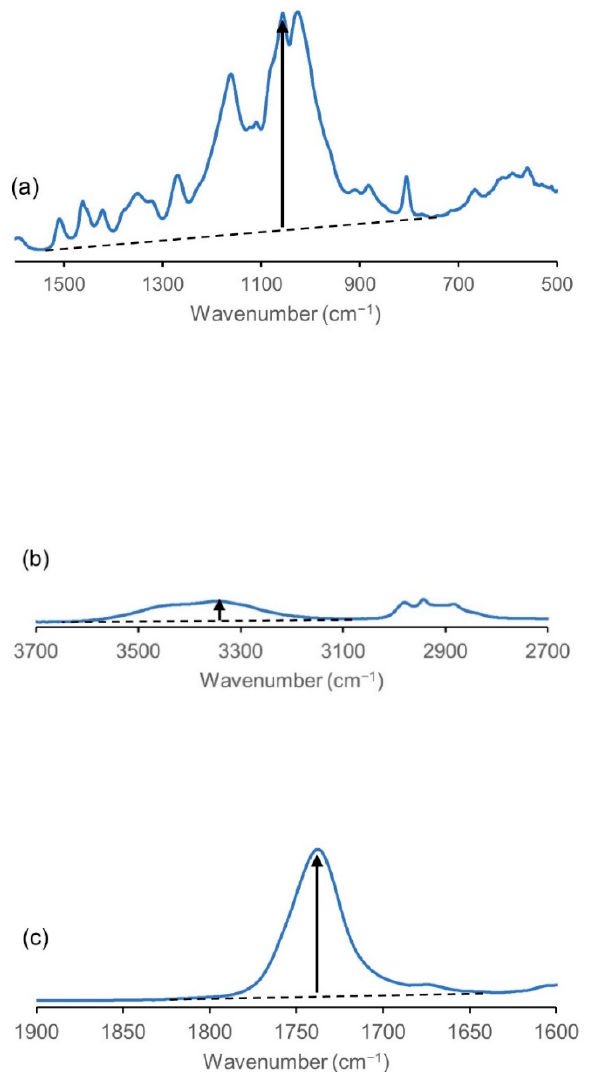
Figure 3. Intensities of the peaks at approximately ( a ) 1060, ( b ) 3340, and ( c ) 1740 cm − 1 in the IR spectrum of the TFAA-W propionylated